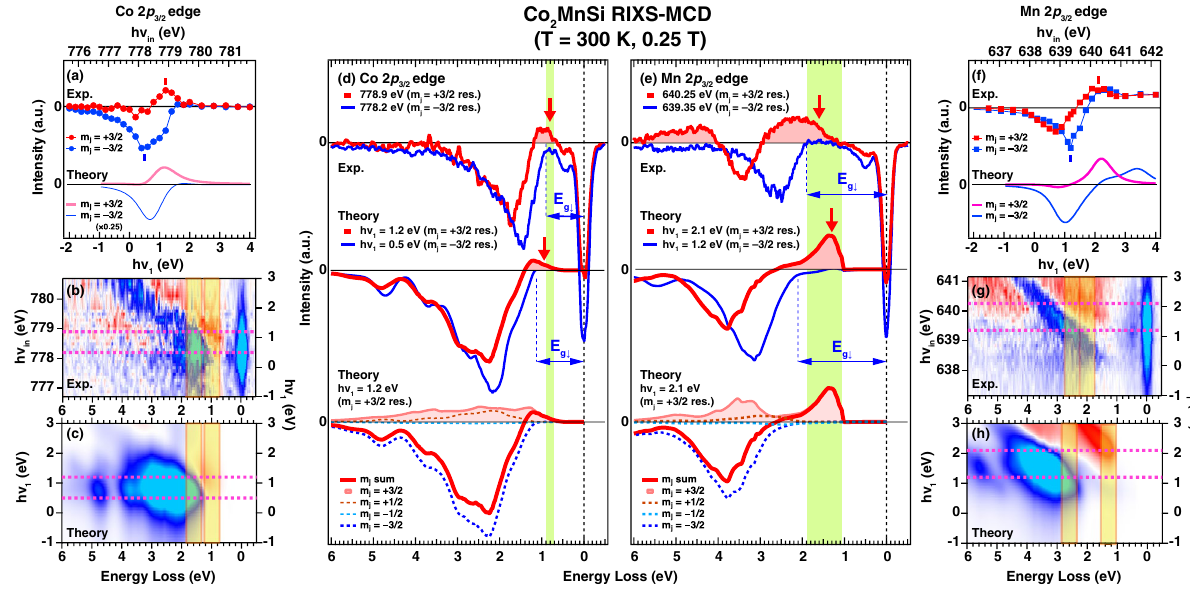
Figure 5. Comparison of the RIXS-MCD spectra between the experiment and theory. Results for the Co(Mn) 2 p 3 / 2 edge are shown in the left (right) half. ( a , f ) Incoming photon-energy dependence of the RIXS-MCD intensity of Co and Mn 2 p 3 / 2 edge at the selected loss energy for m j = ± 3 / 2 components with full energy window of 0.5 eV as indicated by the yellow-colored hatched area in the intensity plot for experiment ( b , g ) and theory ( c , h ). The same color scales as in Figs.3 and 4 are employed here. ( d , e ) The selected RIXS-MCD spectra for the Co (Mn) edge obtained at the m j = ± 3 / 2 resonance energies defined by the peak energies as indicated by vertical bars in ( a , f ), respectively. The resonance energies for the m j = ± 3 / 2 components are also shown by the dashed lines in ( b , c , g , h ). To minimize the experimental artifacts, each spectrum was measured for opposite orientation of the external magnetic field and the obtained spectra were averaged. Moreover, the experimental spectra are scaled to discuss the line shape. The experimental data (top curves in ( d , e )) are compared with theory (middle curves) together with the theoretical m j resolved spectra at m j = + 3 / 2 resonance (bottom curves). The green hatched regions in ( d , e ) are the guides to the eye for showing the energy range, where m j = + 3 / 2 components are observed in the gap of the m j = − 3 / 2